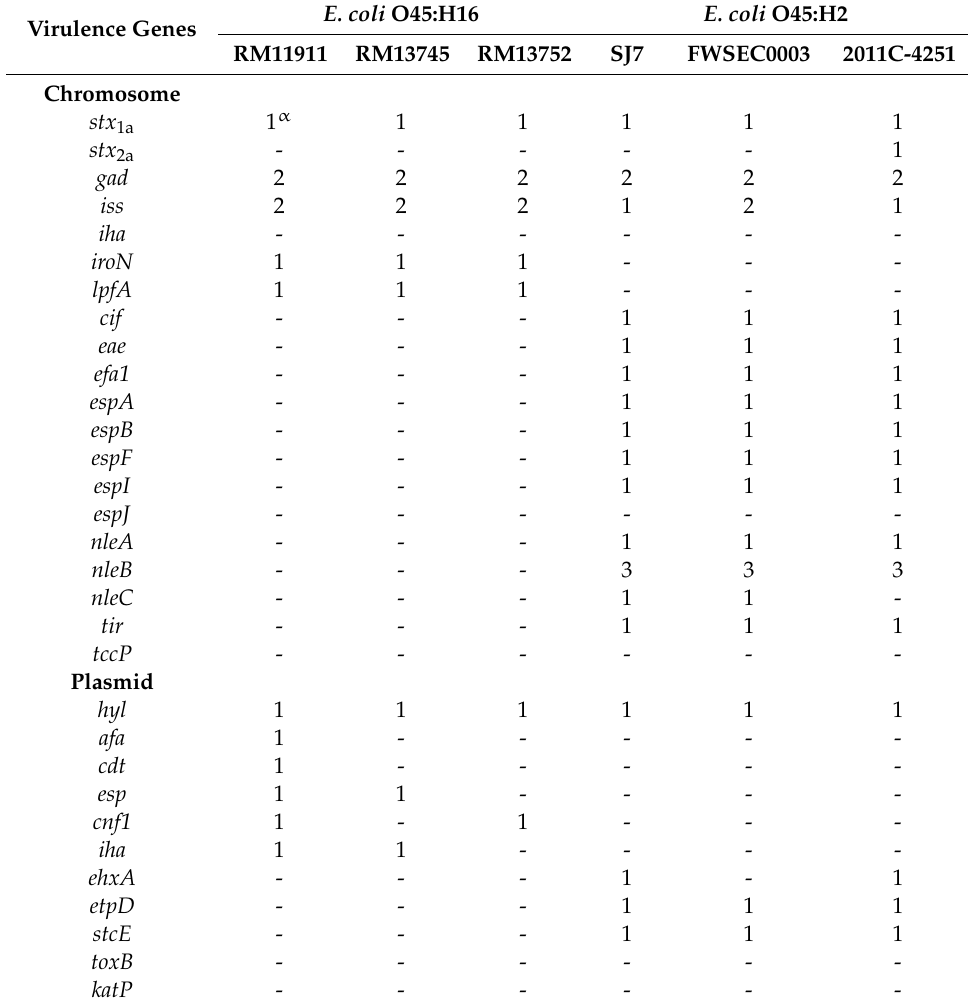
Table 2. The number of various virulence genes present in the chromosomes and plasmids of six STEC O45 strains analyzed in this